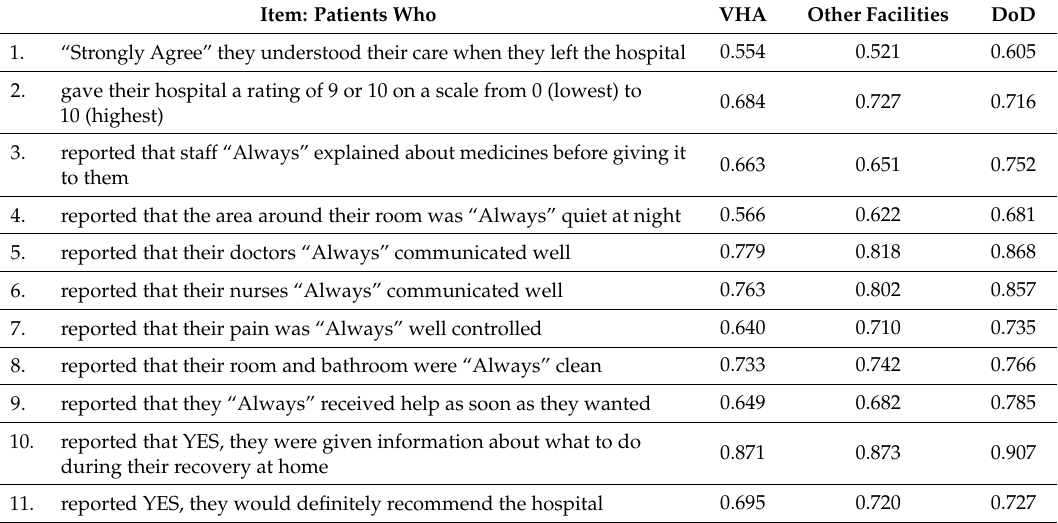
Table 2. Patient satisfaction scores for 1 April 2016 through 31 March 2017 for the VHA, non-VHA and